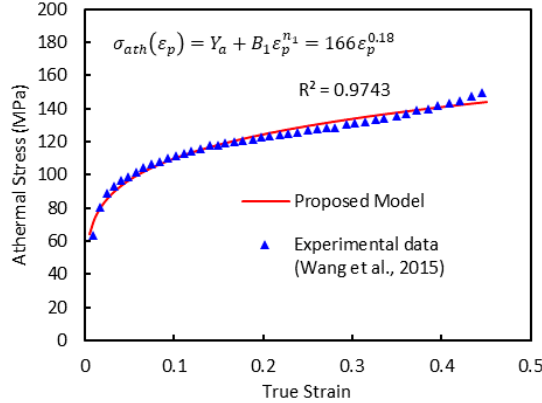
Figure 4. The athermal flow stress-strain curve from the experiments [1] and the proposed model.